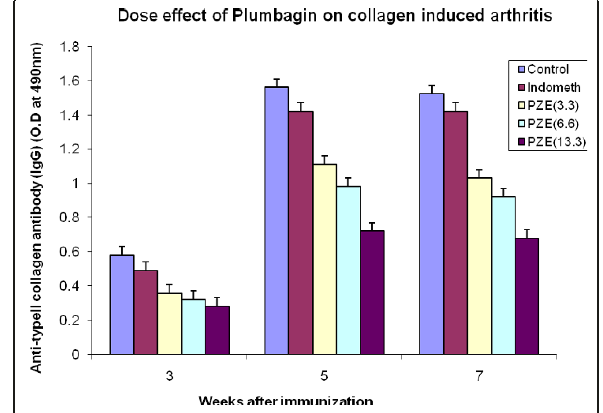
Figure 3 Dose effect of Plumbagin on collagen Type II induced arthritis . Five groups of DBA/1 mice were immunized with 0.1 ml of bovine type II collagen intradermally at the base of the tail. Booster dose was given 3 weeks after primary immunization. Test groups were treated with Plumbagin (3.3 mg/kg), (6.6 mg/kg) and (13.3 mg/kg) and Indomethacin (3 mg/kg) respectively. Control mice were treated with olive oil alone. Retroorbital sera were collected at 3, 5, 7 week intervals after primary immunization for the estimation of anti-type-II collagen antibody (IgG) by ELISA. p-value ≤ 0.05 was